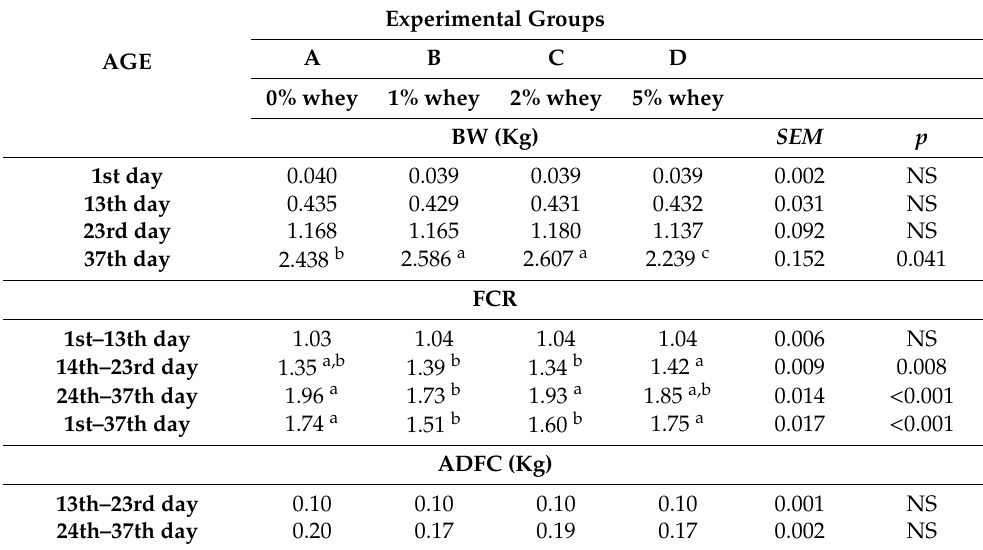
Table 3. E ff ect of whey in various concentrations in poultry diets on the body weight (BW), feed conversion ratio (FCR) and average daily feed consumption (ADFC). Experimental Groups A AGE